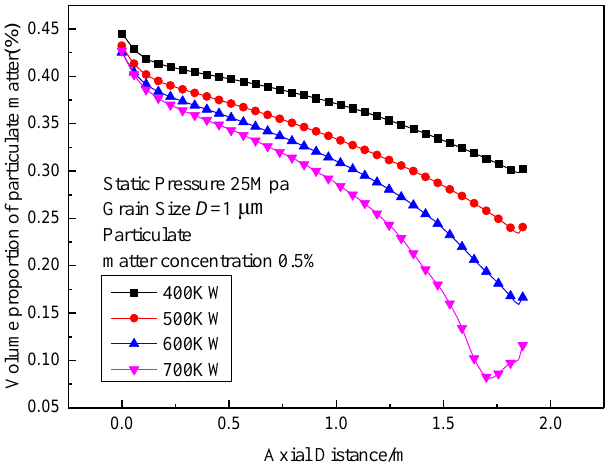
ff erent heating powers.